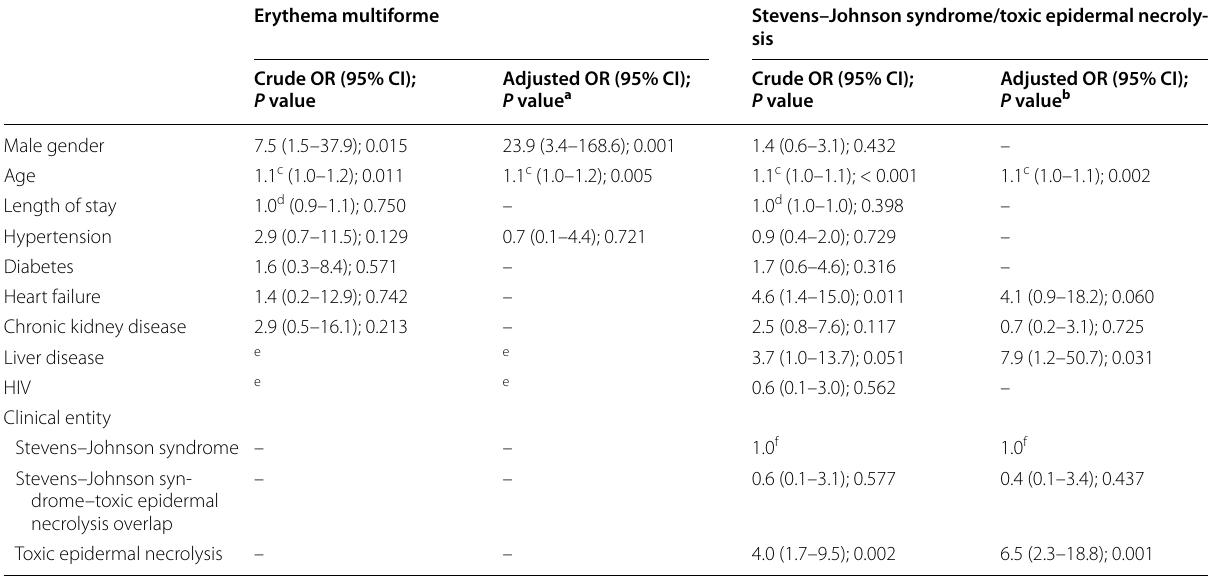
OR odds ratio, CI confidence interval a Adjusted for gender, age, and hypertension b Adjusted for age, Stevens–Johnson syndrome, toxic epidermal necrolysis, heart failure, chronic kidney disease, and liver disease